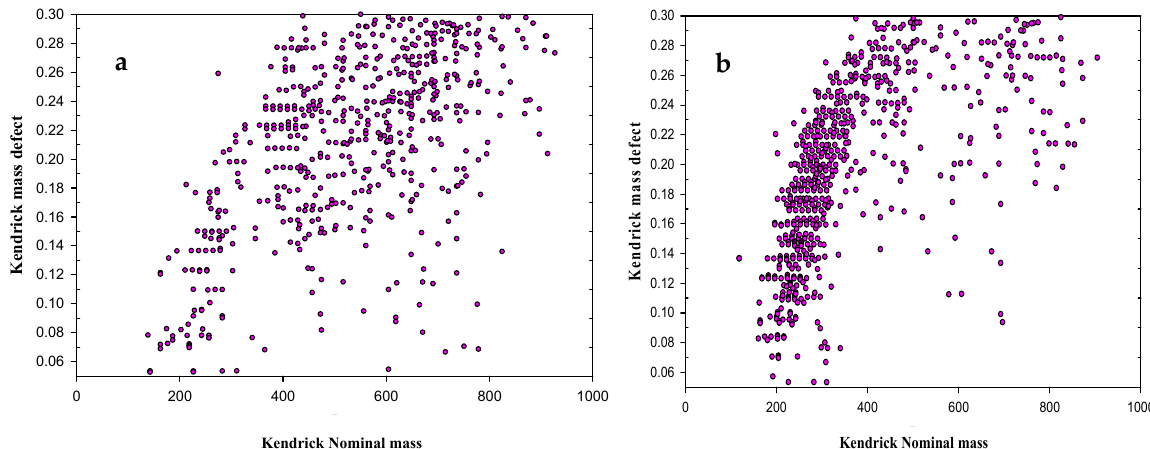
Figure 13. Kendrick mass plots of the O 1 -O 10 species found in the not-treated WSF of crude oil ( a ) and after 1-h of sonophotocatalytic treatment ( b ).